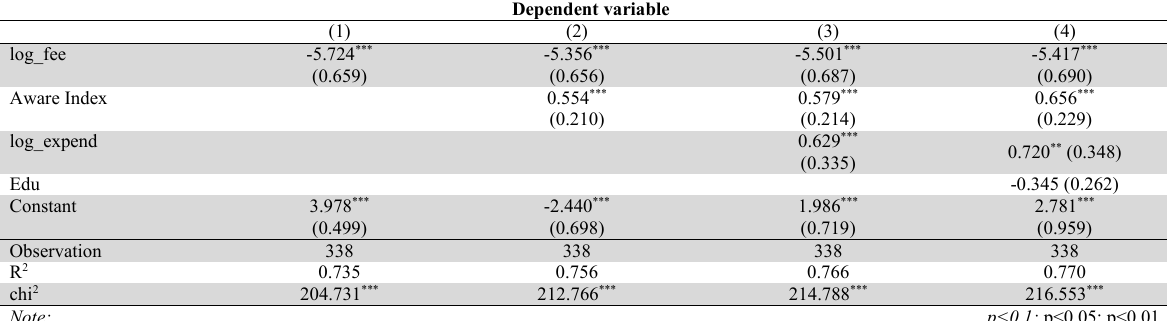
Households water connection model (Logit